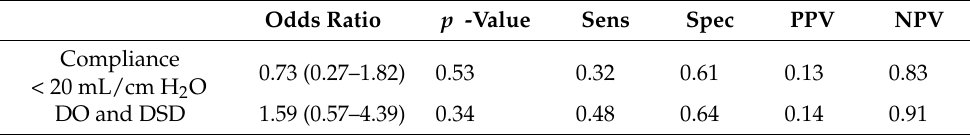
Table 5. p -values and predictive parameters of EDSS and risk factors for UUTD. Odds Ratio p -Value